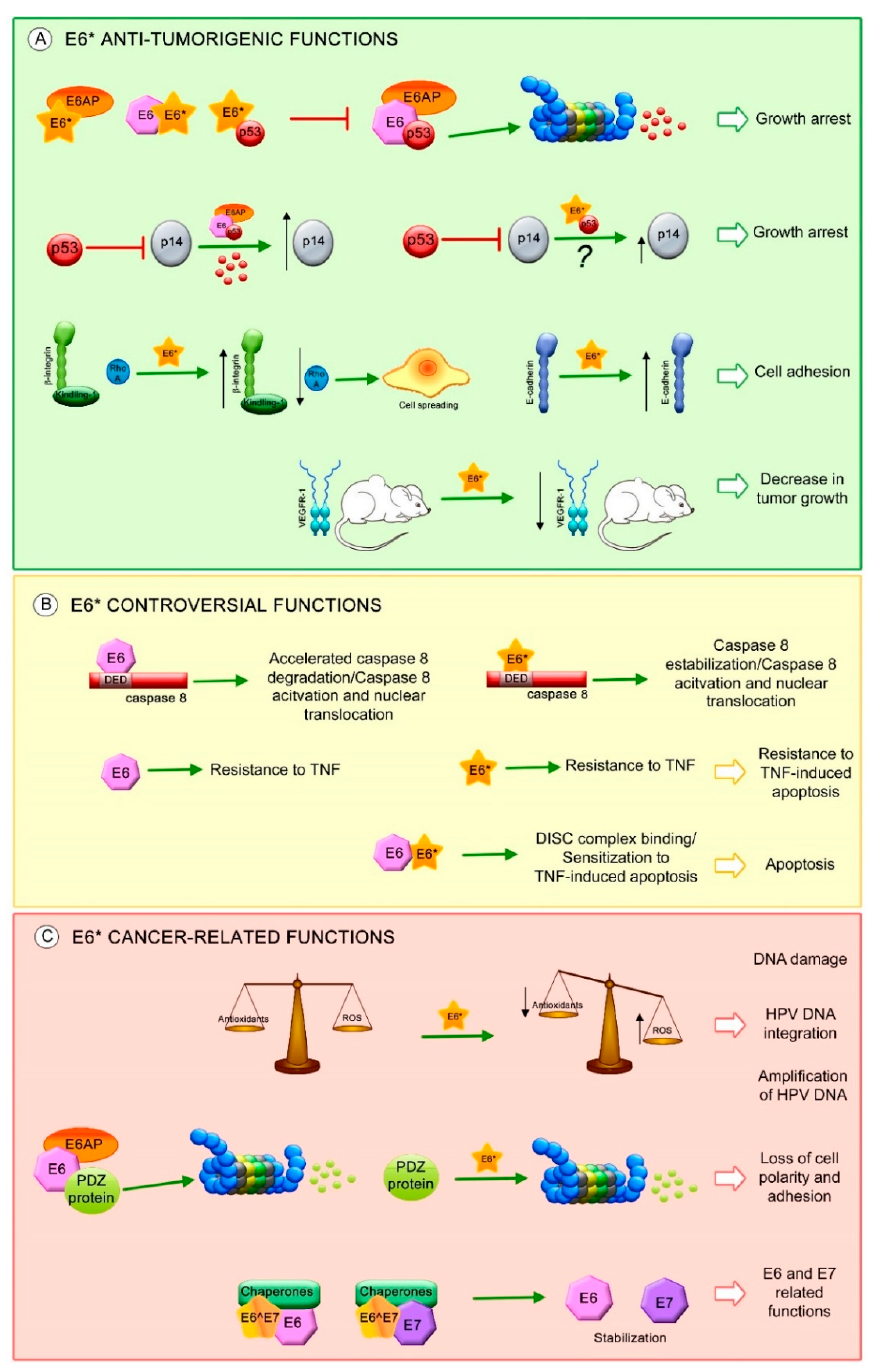
Figure 4. E6* isoform-related functions. Proposed E6* functions involved in ( A ) anti-tumorigenic effects, such as: increase in growth arrest through inhibition of E6-mediated p53 degradation and increase in p14 protein levels possibly through E6*/p53 interaction (?), increase in cell adhesion by the activation of β -integrin signaling and overexpression of E-cadherin, decrease in tumor growth associated with a reduction in VEGFR-1; ( B ) Controversial effects of E6* in apoptosis regulation; and ( C ) Carcinogenic characteristics, such as: promotion of DNA damage by ROS, which may allow HPV DNA amplification and integration into the host genome, degradation of postsynaptic density-95/discs large/zonula occludens-1 domain (PDZ) containing proteins involved in cell polarity and adhesion and stabilization of E6 and E7 oncoproteins. The red T-bars indicate inhibition, the green arrows show induction of the related process, the black arrows depict an increment or a reduction in protein levels.